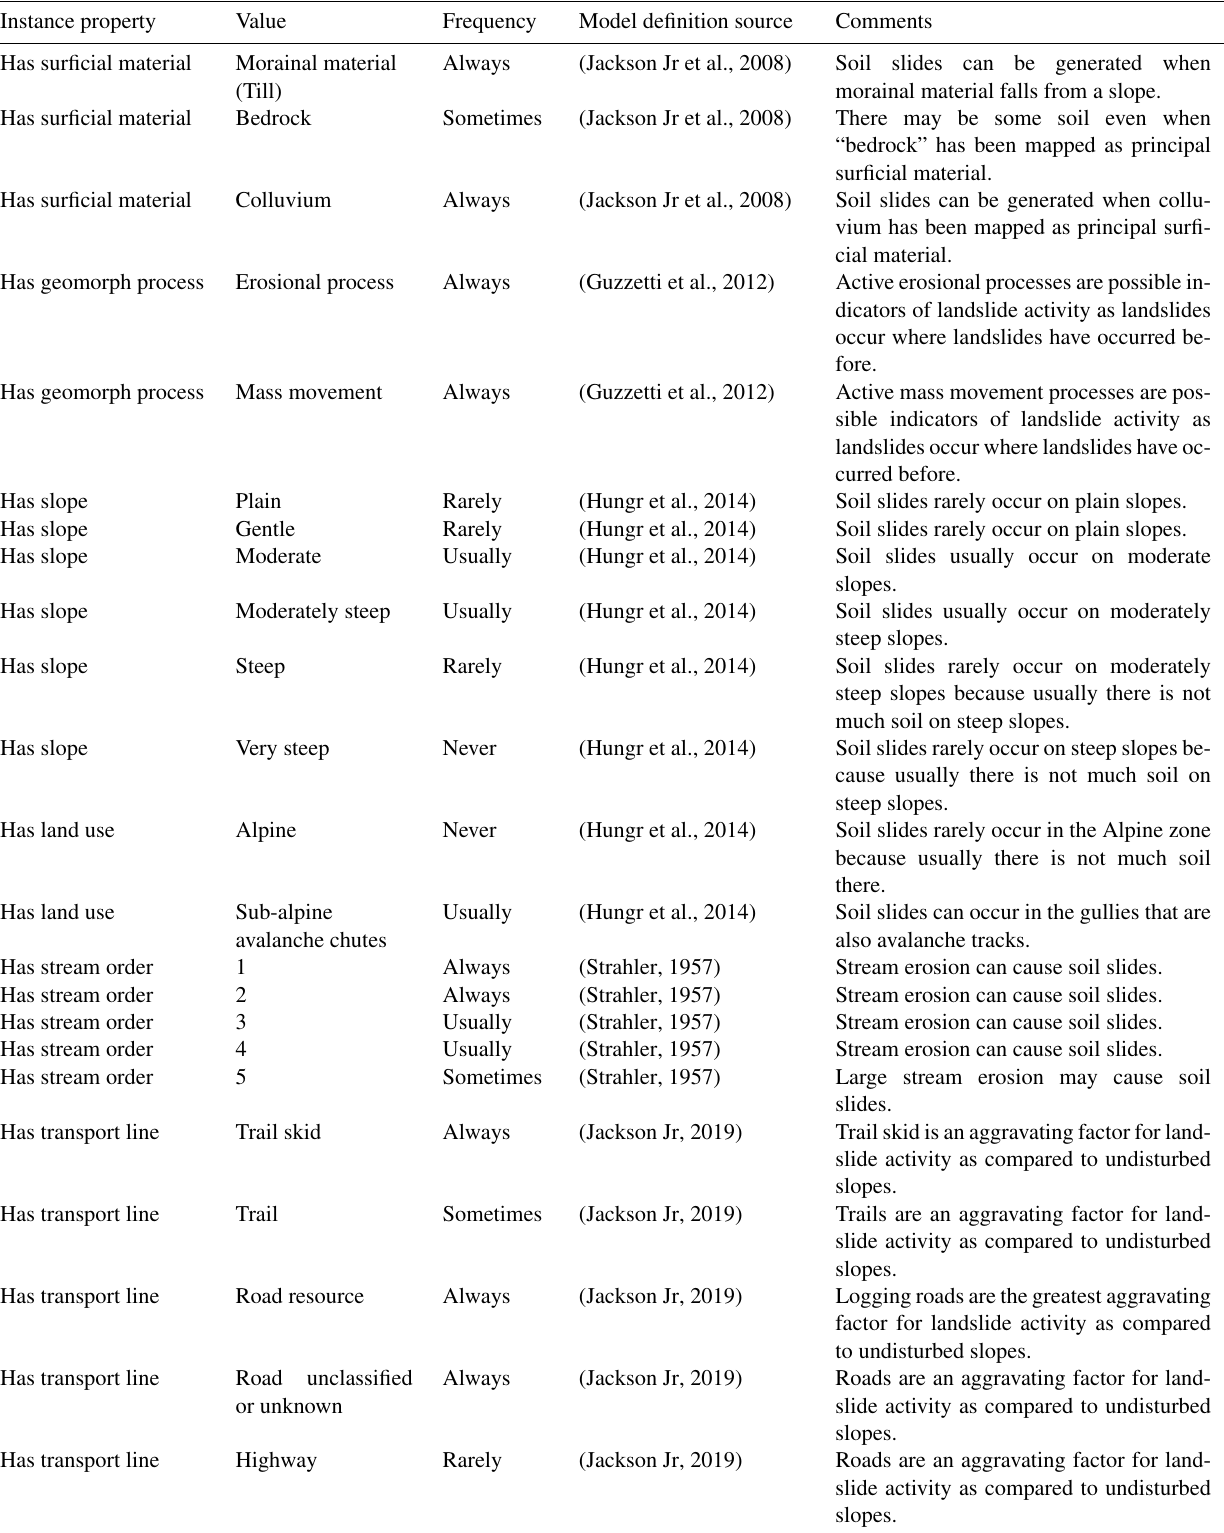
Table C3. Slides in soil model https://italy.minervageo.com/slides-in-soil/ (last access: 26 October